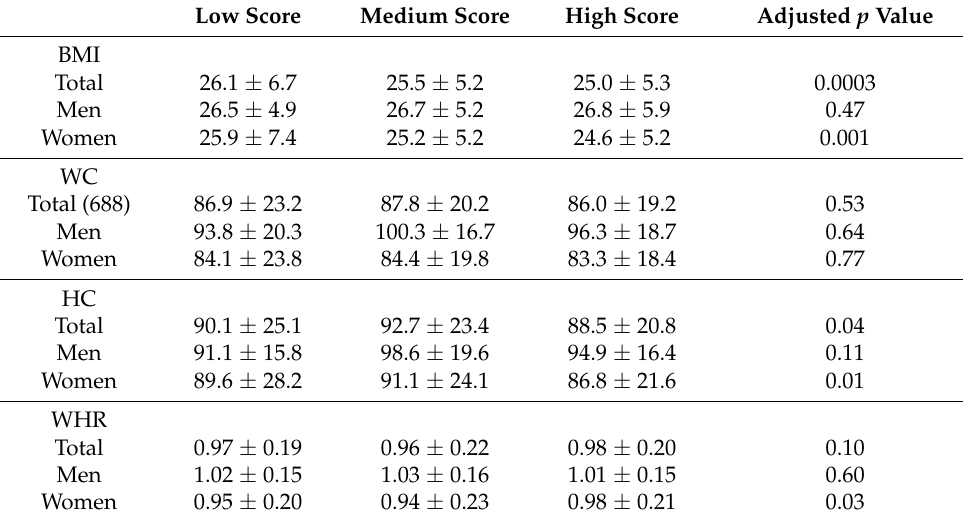
Table 4. Association between adherence to MedDiet score and obesity risk